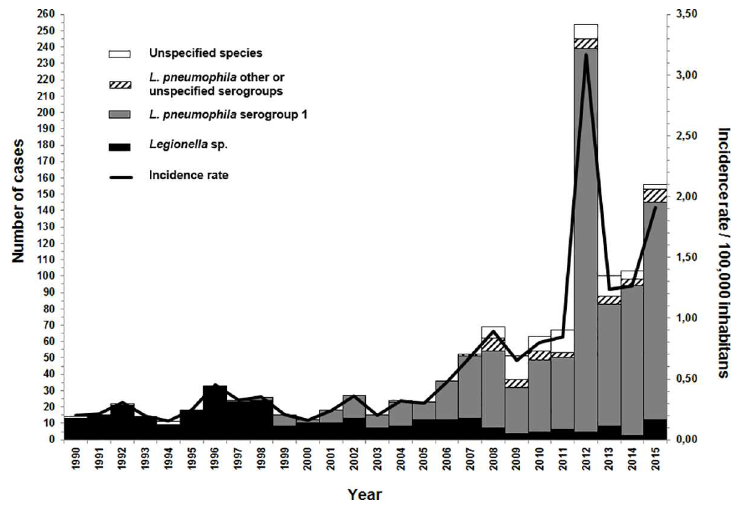
Fig 1. Number of cases per year, by species and serogroup, and annual incidence rate of legionellosis, province of Quebec,